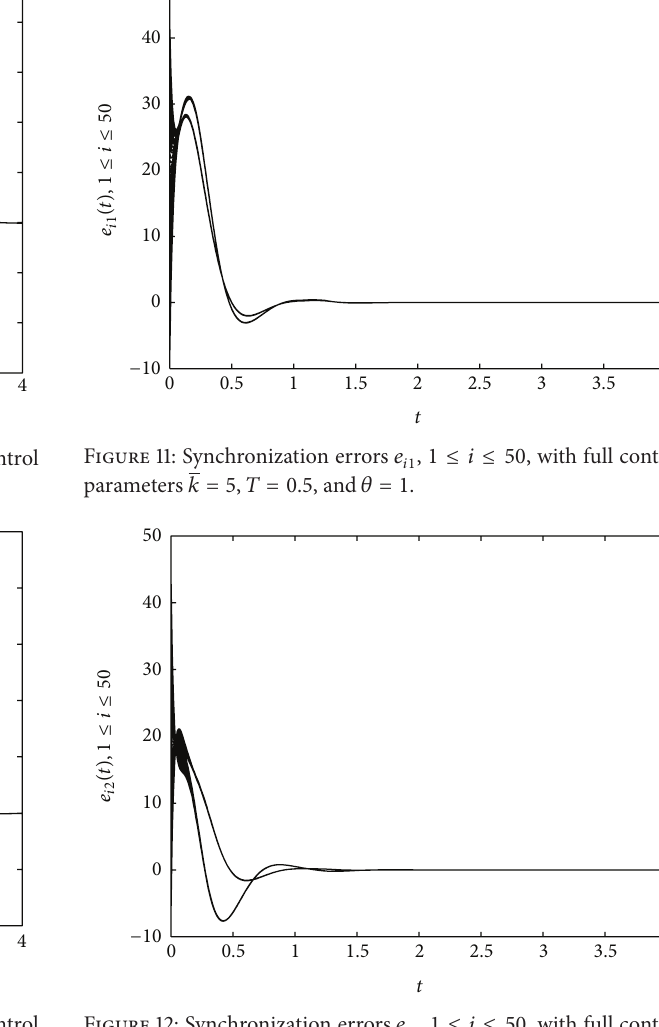
Figure 12: Synchronization errors 𝑒 𝑖 2 , 1 ≤ 𝑖 ≤ 50, with full control parameters 𝑘 = 5, 𝑇 = 0 . 5, and 𝜃 = 1.